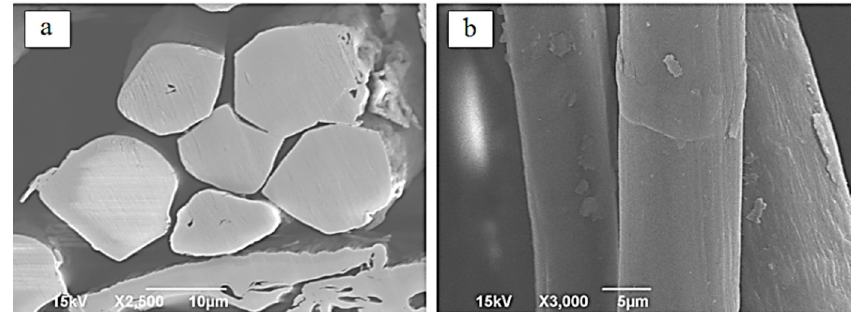
Figure 1. SEM images of ( a ) the cross-section of flax fiber and ( b ) the surface of the fiber used in this study.